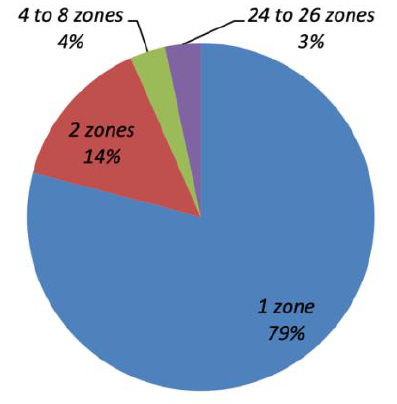
Figure 6. Artefacts with metal wear (N=91). Distribution of the metal traces and their frequency (according to the number of affected